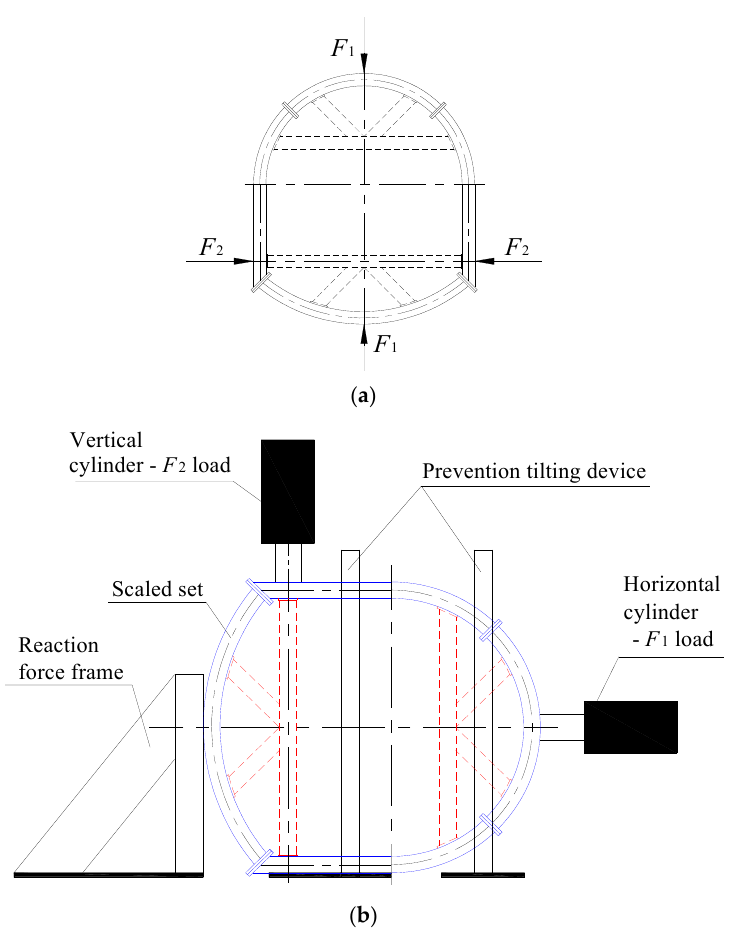
Figure 5. Loading state on scaled sets: ( a ) schematic of loading state; ( b ) loading state in